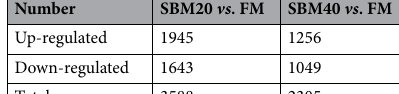
Number SBM20 vs . FM SBM40 vs .